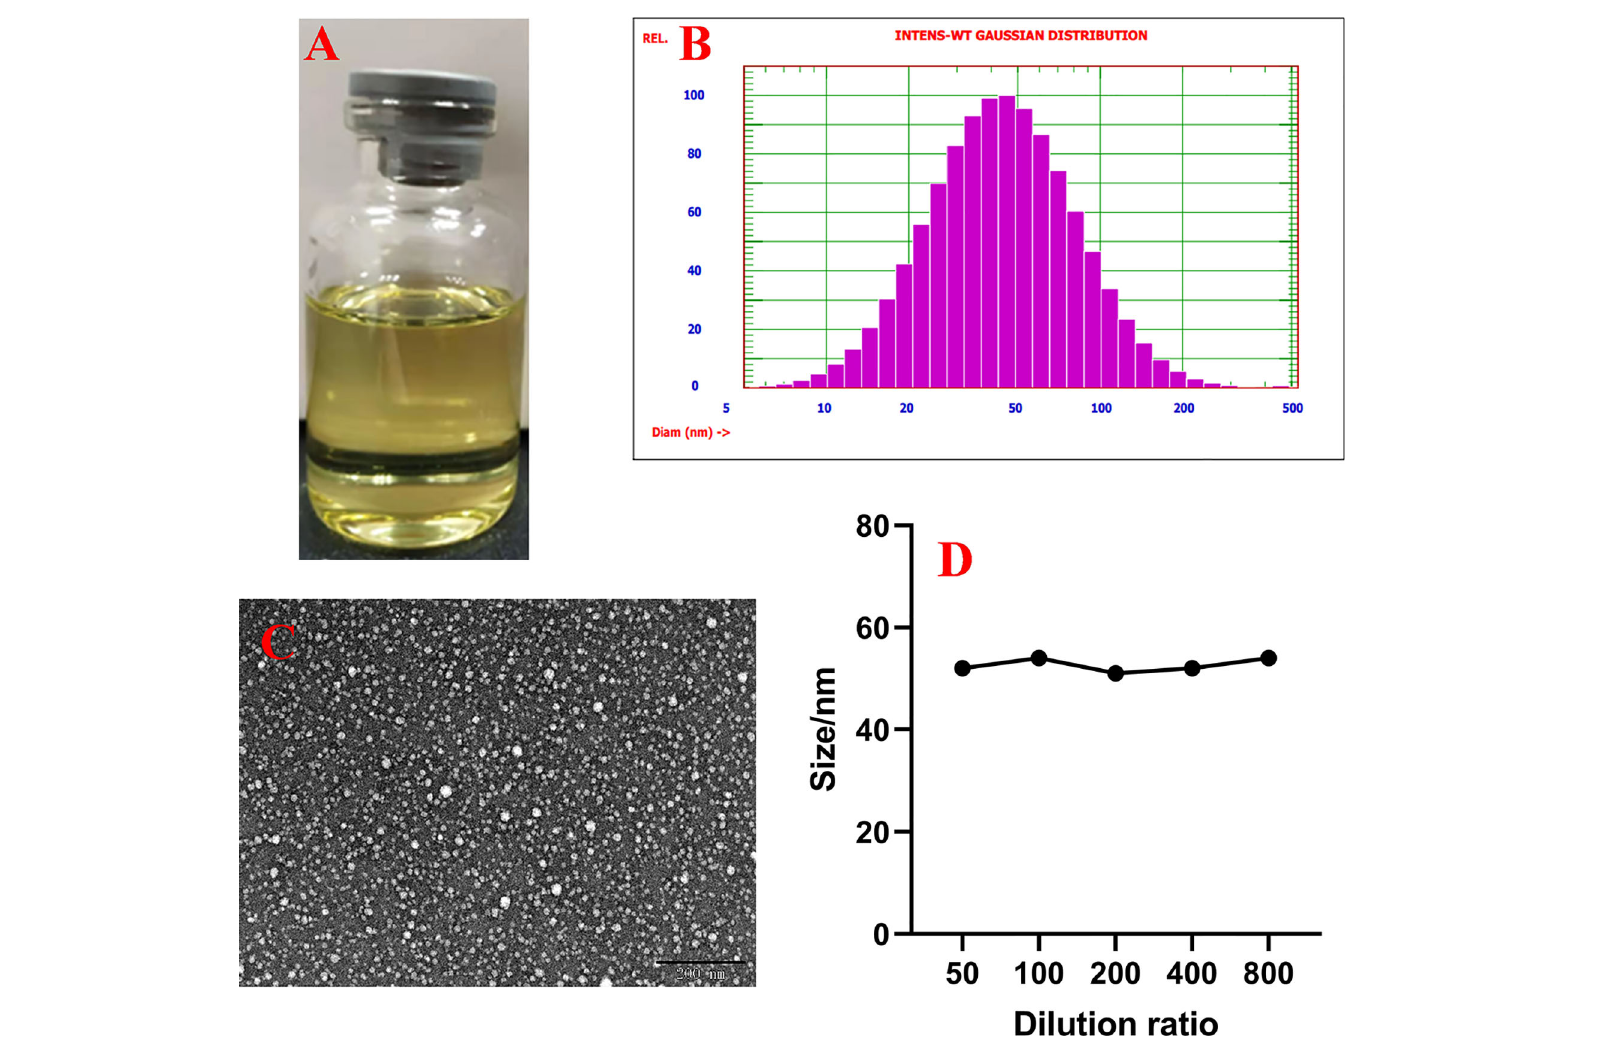
FIGURE 1 | Characteristics of SME-HEO. (A) Appearance of SME-HEO. (B) Particle size and distribution of SME-HEO. (C) Microstructure of SME-HEO. (D) Relationship between particle size and dilution ratio of